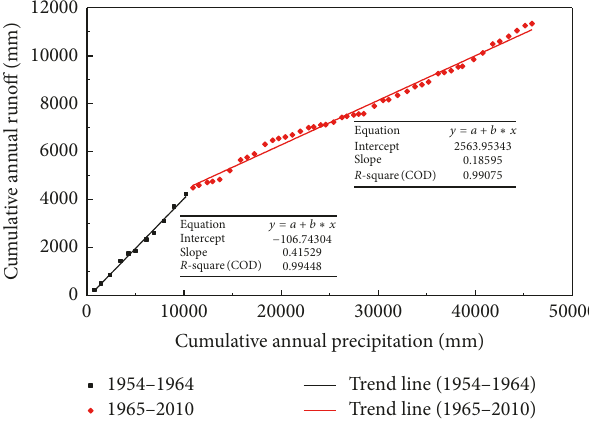
Figure 6: Double mass curve of precipitation and runoff depth.